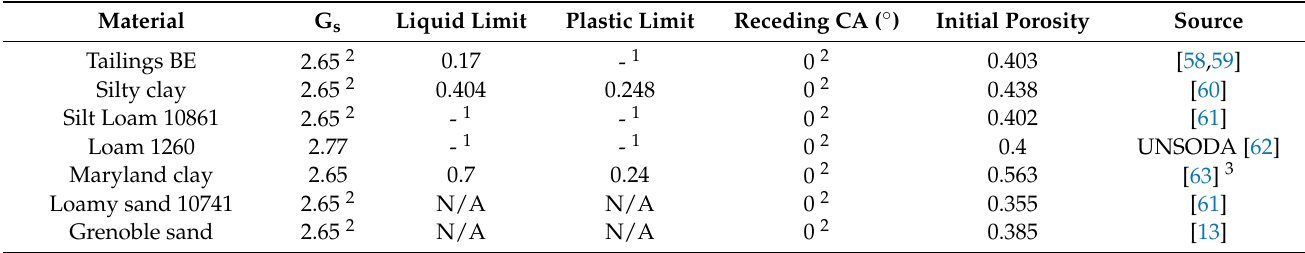
Table 1. Specific gravity (G s ), Atterberg limits, receding contact angle (CA), and initial porosity of each soil being modelled. The source for each soil’s properties is